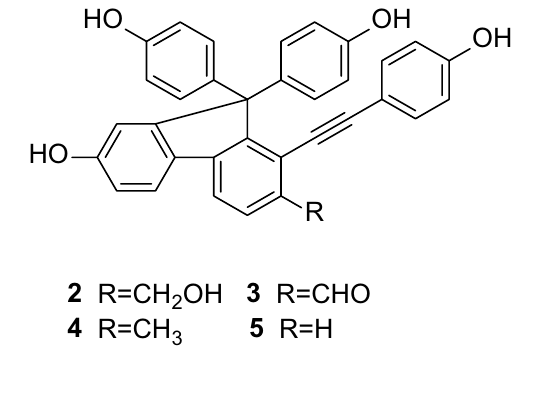
Fig. 1 Structures of compounds 1 -